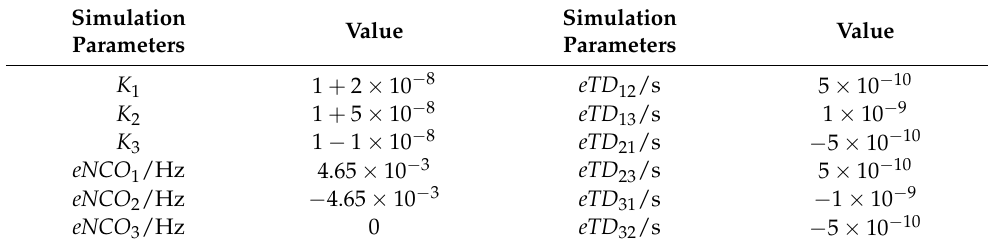
Table 3. Simulation parameters.